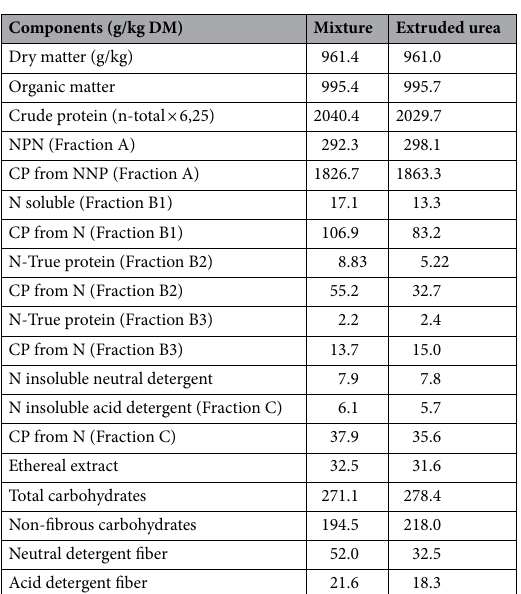
Table 1. Nutritional characterization of the mixture of ground corn and urea, and extruded urea.